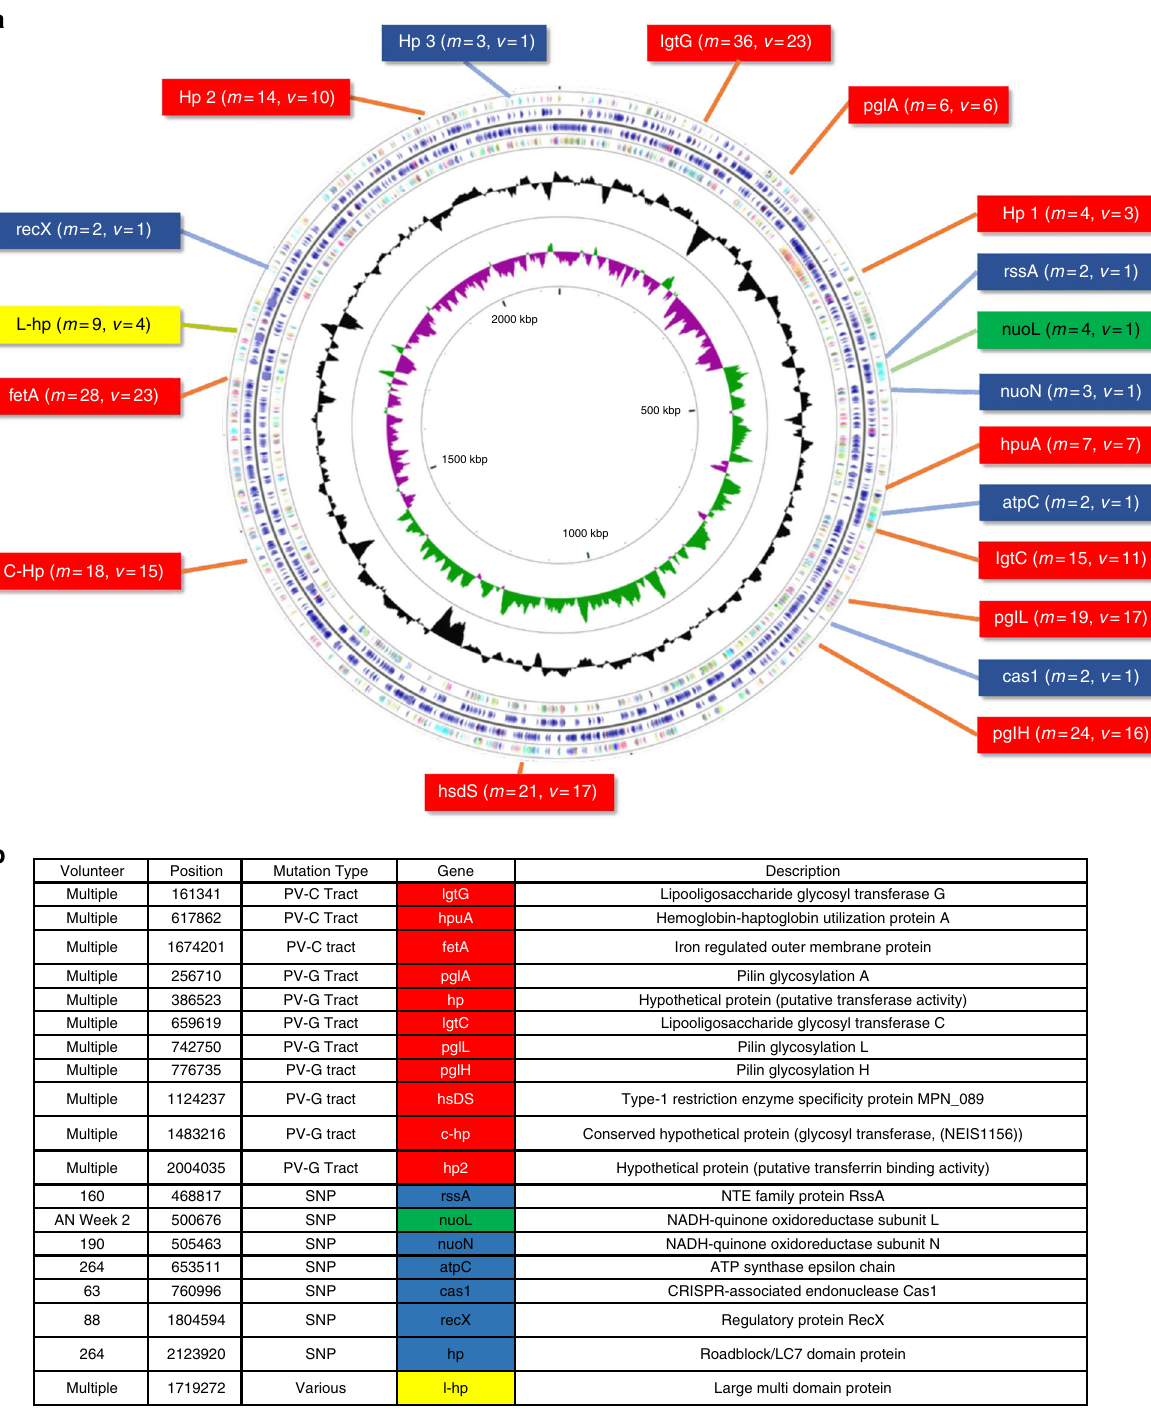
Fig. 1 a , b Mutations that occurred in isolates recovered over 6 months of nasopharyngeal carriage are outlined as follows: changes to repetitive tracts of phase-variable, contingency loci (Red), genes in which SNPs were persistently detected across multiple volunteers (Blue), including an example from the short-term, in vitro VS in vivo study (Green) and the sole gene in which various mutations discovered across multiple timepoints and volunteers (Yellow). m refers to the number of mutations detected in a given gene across v volunteers. The genes are placed in positions relative to their approximate location in the N. lactamica Y92-1009 genome. b Volunteers in which Single-Nucleotide Polymorphisms (SNPs) were seen are speci fi ed in the Volunteer column. Mutations which affected multiple volunteers are quanti fi ed in the accompanying fi gure above. Mutation locations are indicated in the Position column. The type of mutation is given in the mutation column where C tract/G tract refers to a homopolymeric region of cytosine/ guanine repeats where insertions and deletions occurred. PV denotes